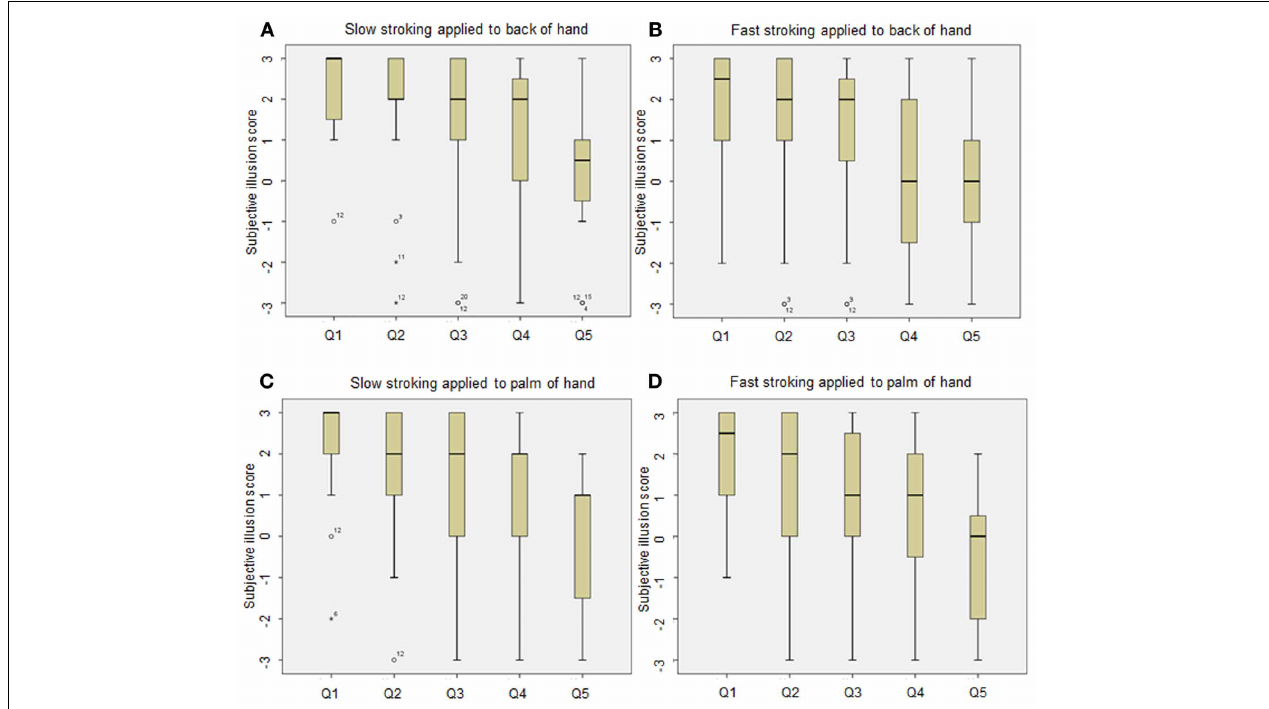
FIGURE 1 | Box plots displaying questionnaire responses for each condition ( A , slow stroking to back of hand; B fast stroking to back of hand; C , slow stroking to palm of hand and D , fast stroking to palm of hand): (Q1: It felt as if I was feeling the stroking touch in the location where I saw the rubber hand touched. Q2: It felt as if the rubber hand were my hand. Q3: It seemed as though the touch I felt was caused by the touching on the rubber hand. Q4: It felt as if my (real) hand was